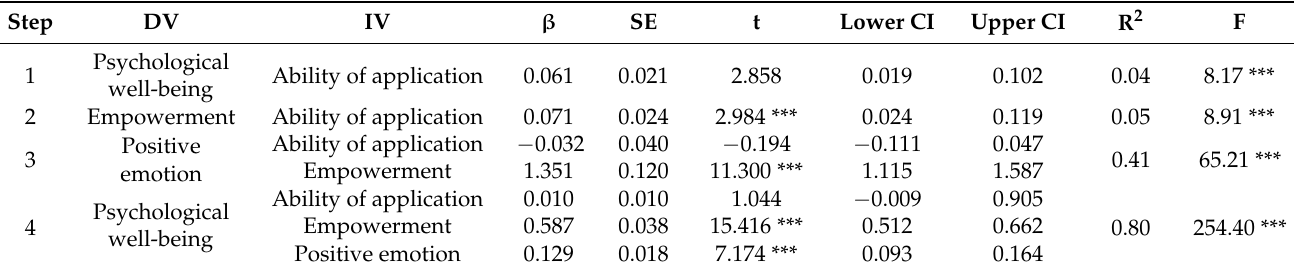
Table 6. Mediation effect of empowerment and positive emotion.